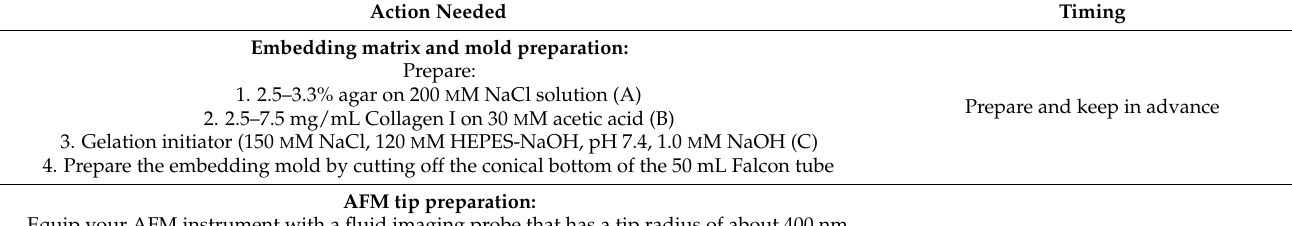
Table 2. Protocol for live brain slices preparation and AFM